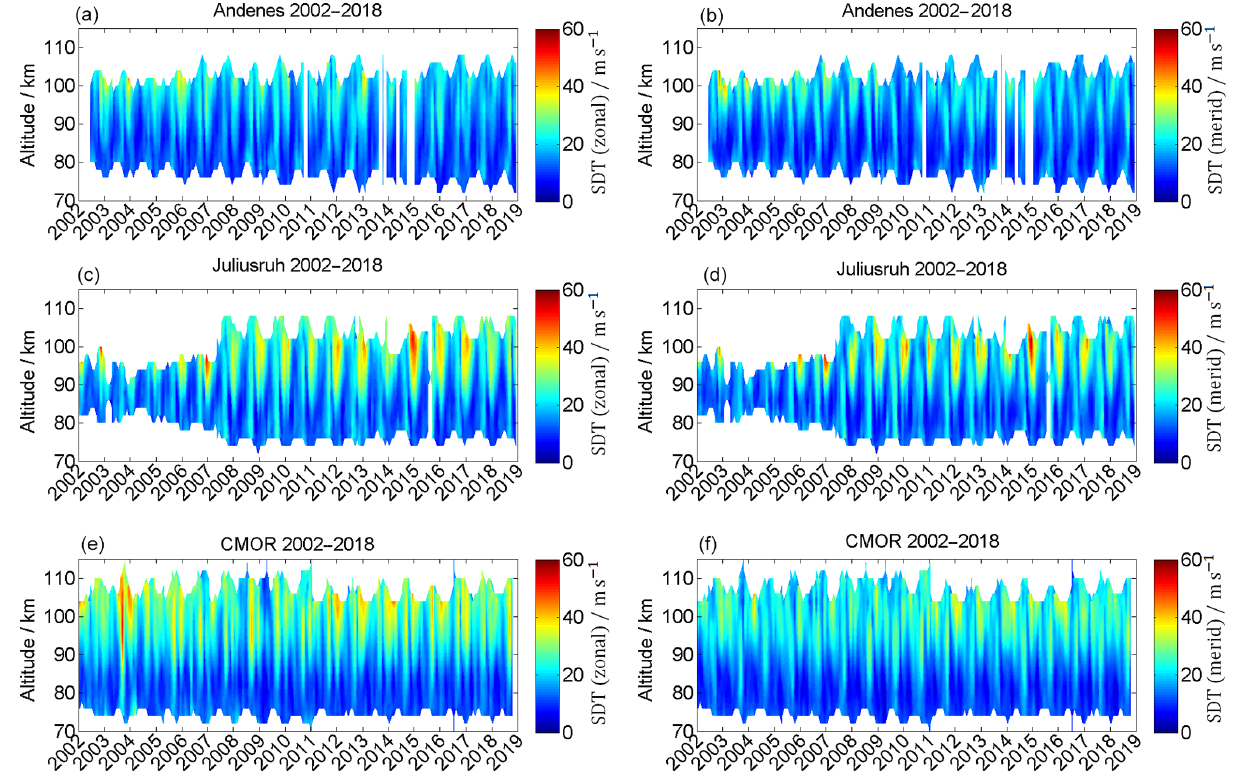
Figure 11. Same as Fig. 7 but for the semidiurnal tidal components.